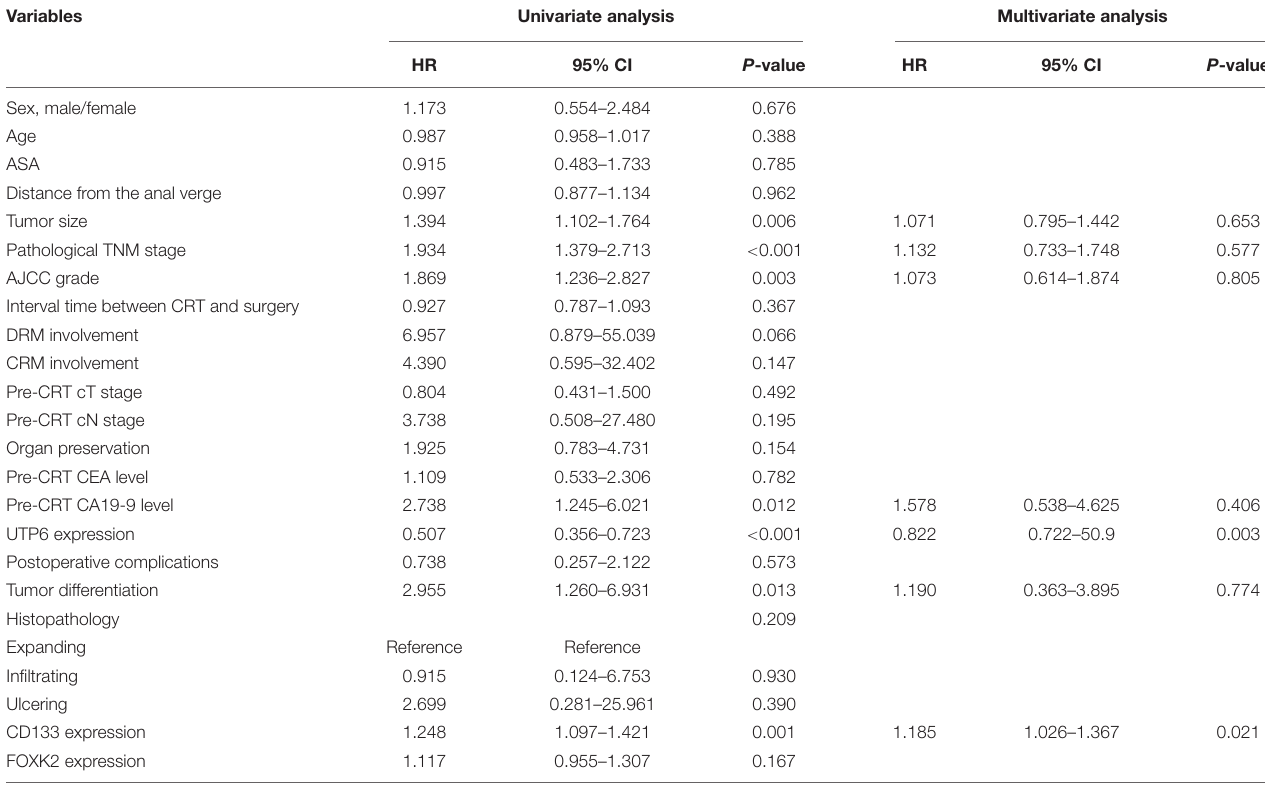
TABLE 3 | Cox regression analysis of predictive factors for overall survival in the training dataset patients with LARC following CRT ( n =